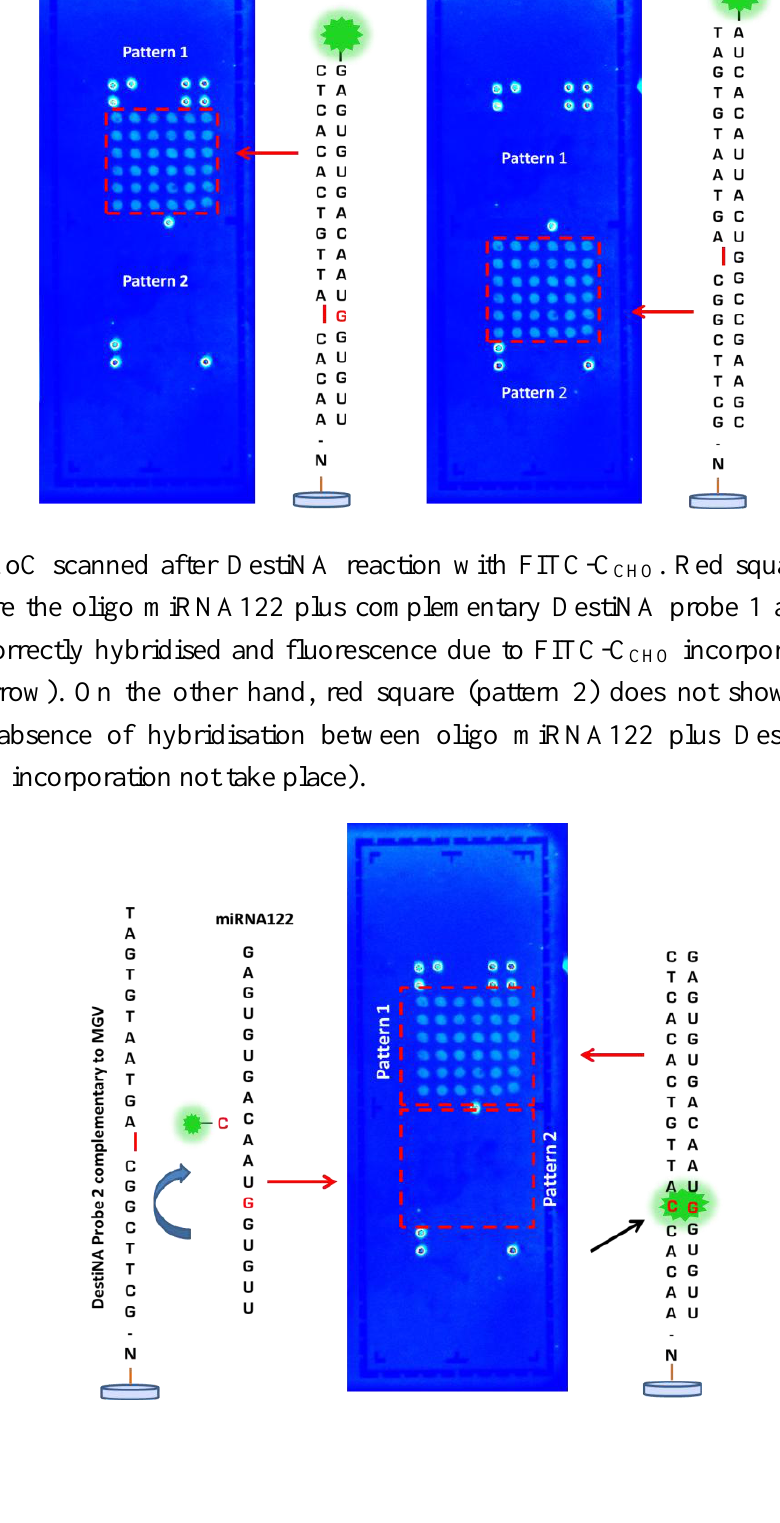
miRNA122-FITC ( left ) or MGV-FITC ( right ). LoCs were scanned using a 200 ms exposure time using emission and detection filters appropriate for FITC.